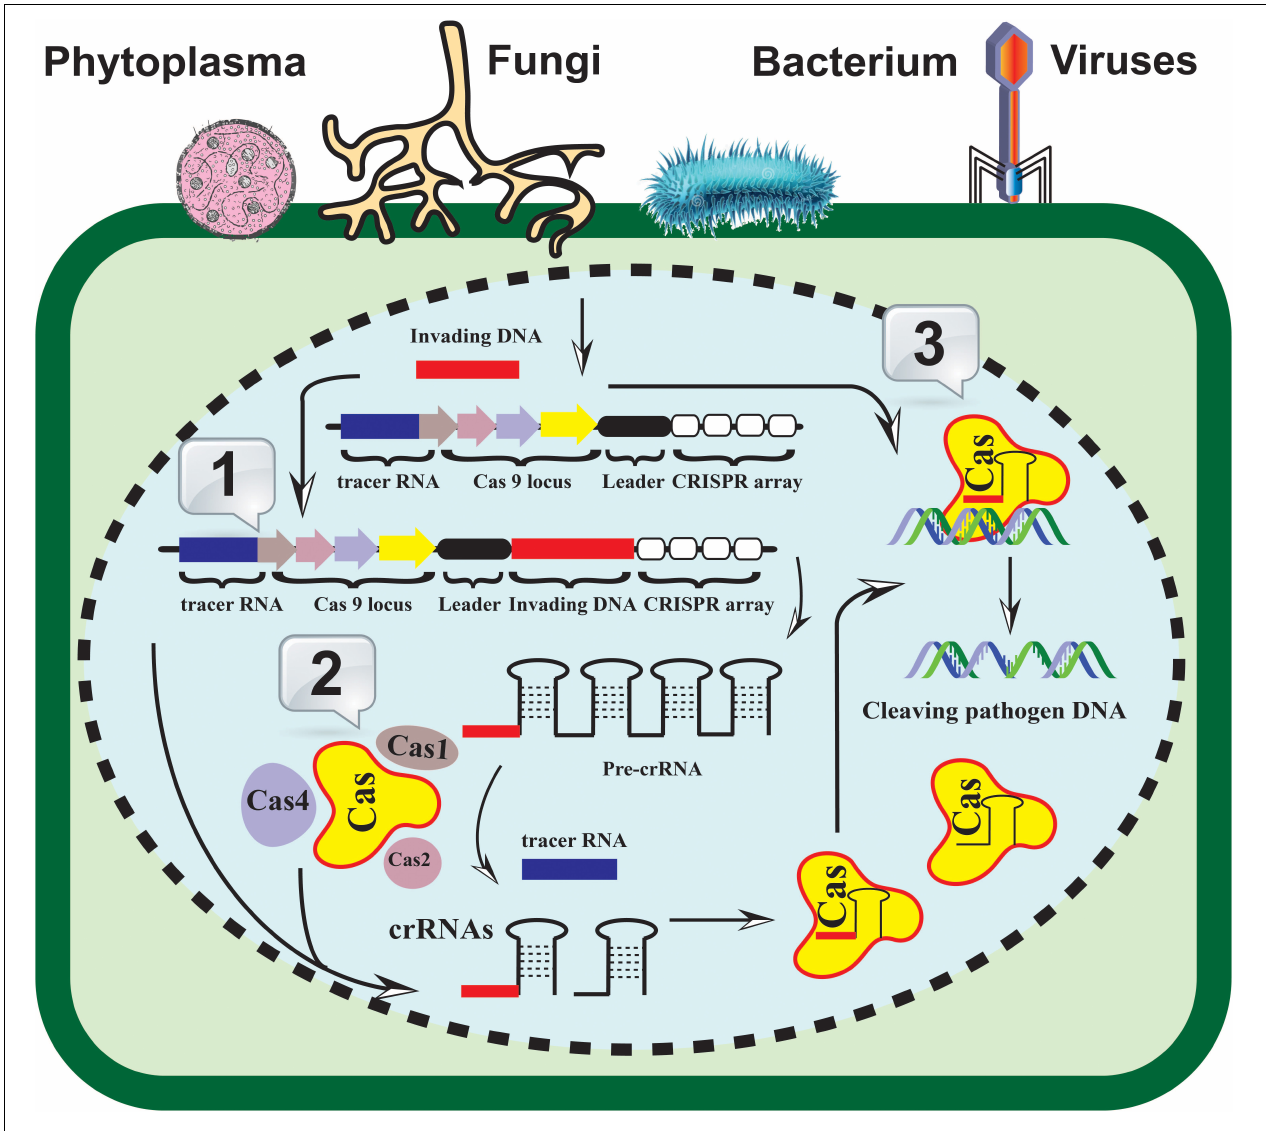
FIGURE 1 | A generalized CRISPR-Cas-based resistance induction model. The identification, recruitment, and cleavage of the invading pathogen’s nucleic acid (fungi, bacteria, viruses, and/or phytoplasma) are achieved in three fundamental steps. 1. Acquisition: the invaded DNA (bar in red color) is integrated into the CRISPR-array (white rectangles) as new spacers; 2. Expression: the pre-CRISPR and crRNAs machinery is triggered and expressed in the invaded cell; 3. Interference: the mature crRNA hybridized to the invading pathogen genome and subsequently recognized by the Cas proteins. The coordination of Cas helicase and nuclease with CRISPR RNA machinery results in the invader’s nucleic acid